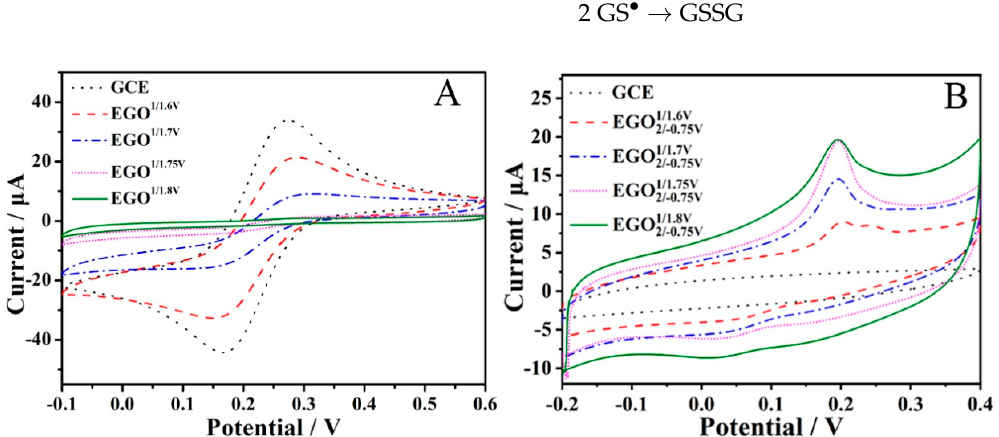
(cid:2875)(cid:2873)(cid:2869) / (cid:2926)(cid:2925)(cid:2930)(cid:2915)(cid:2924)(cid:2930)(cid:2919)(cid:2911)(cid:2922) in 5 mM Fe(CN) 63 − /4 − ( A ) and 5 mM GSH in 5 mM Fe(CN) 63 − /4 − ( A ) and 5 mM GSH 2/ − 0.75 (cid:2870) / (cid:2879)(cid:2868) .